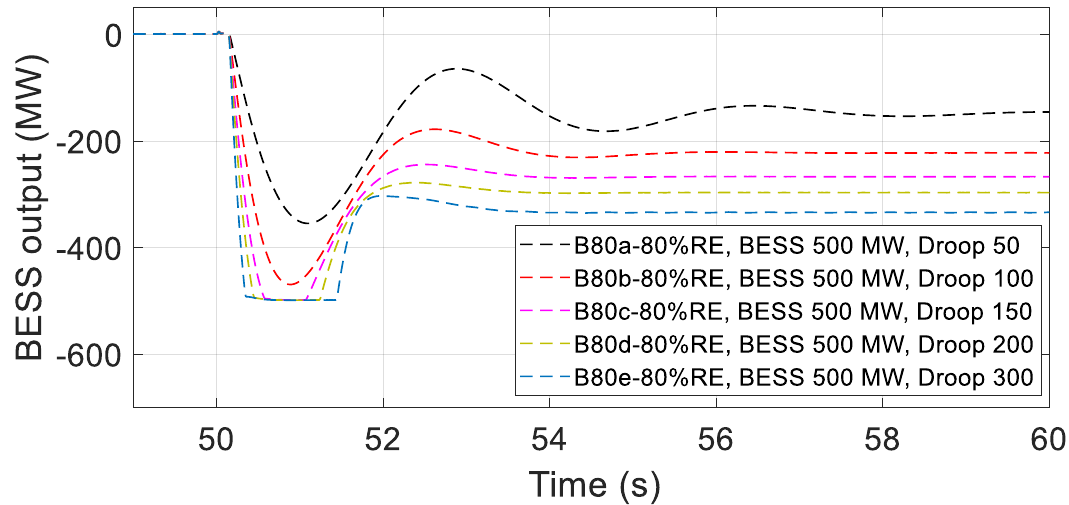
Figure 9. 500 MW BESS output power under different droop coefficients when 80% RE penetration occurs.